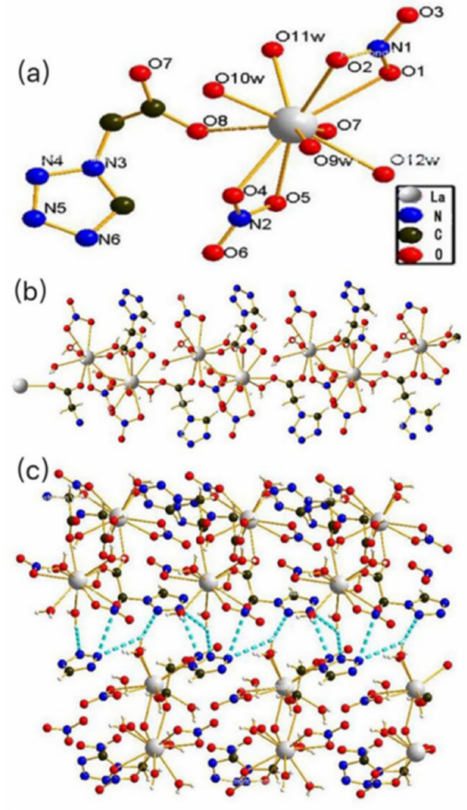
Figure 1. ( a ) The coordination environment of La(III); ( b ) one-dimensional chain of complex 1 with left-handed chirality; ( c ) three-dimensional network structure of complex 1 connected by O–H ... N hydrogen